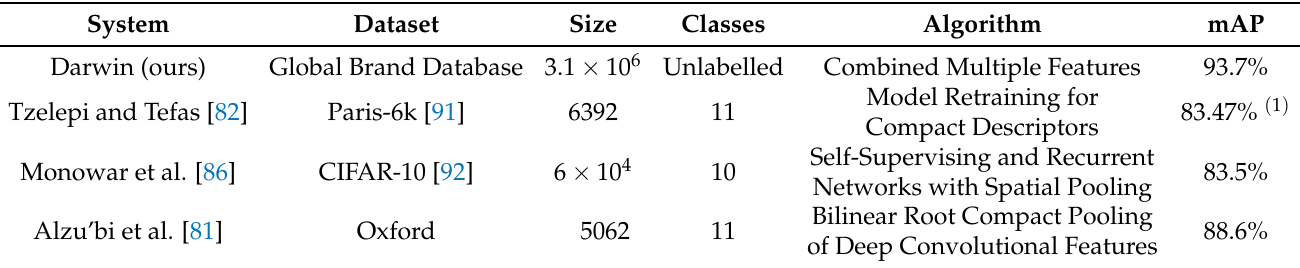
Table 4. Proposed System comparison with state-of-the-art deep learning CBIR